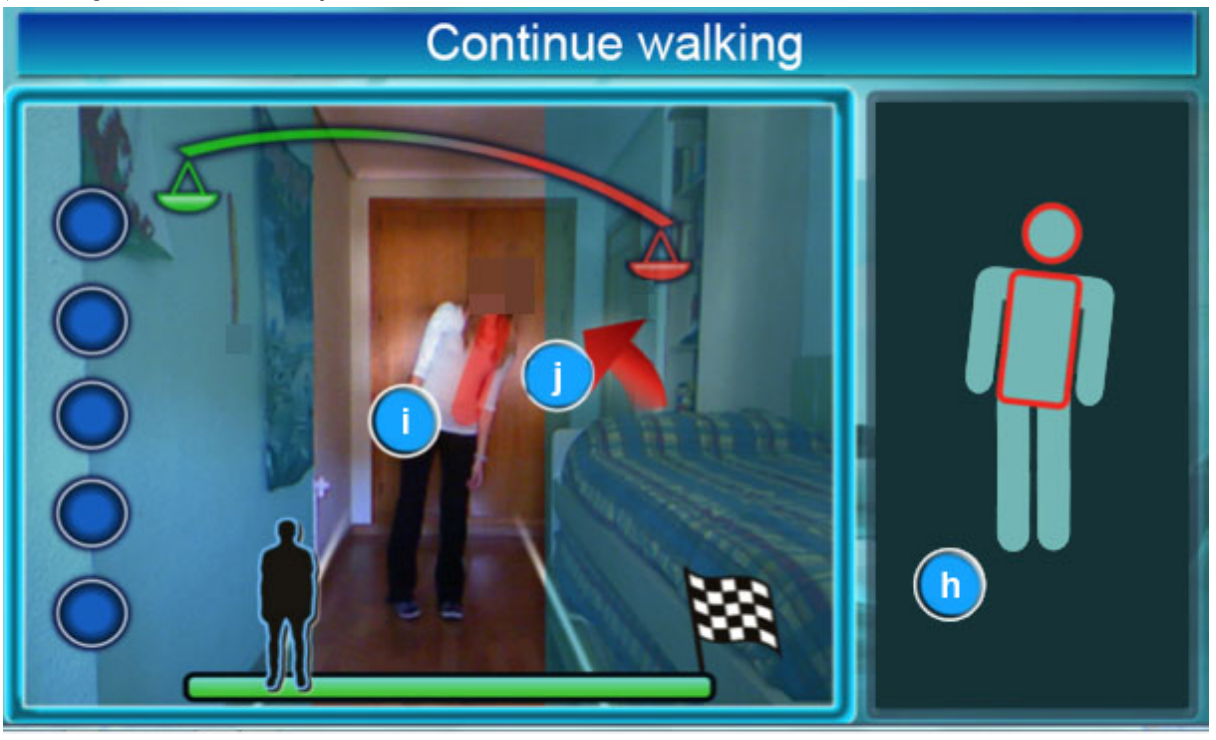
Figure 7. System screenshot which shows an overview of a complete rehabilitation exercise. The interface elements in the screenshot are: (h) animation area, (i) misaligned bones corrector and (j) corrective